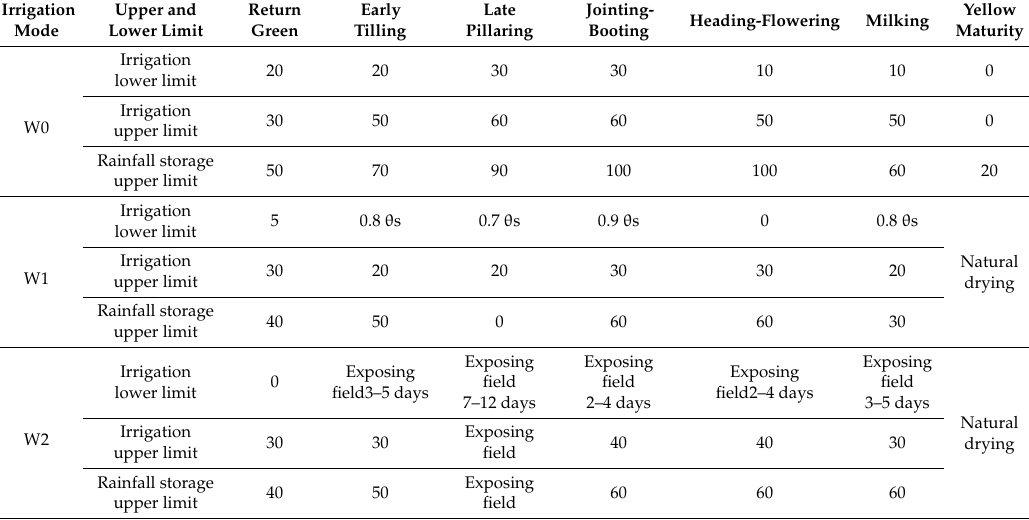
Table 1. Field water control standards for different irrigation modes